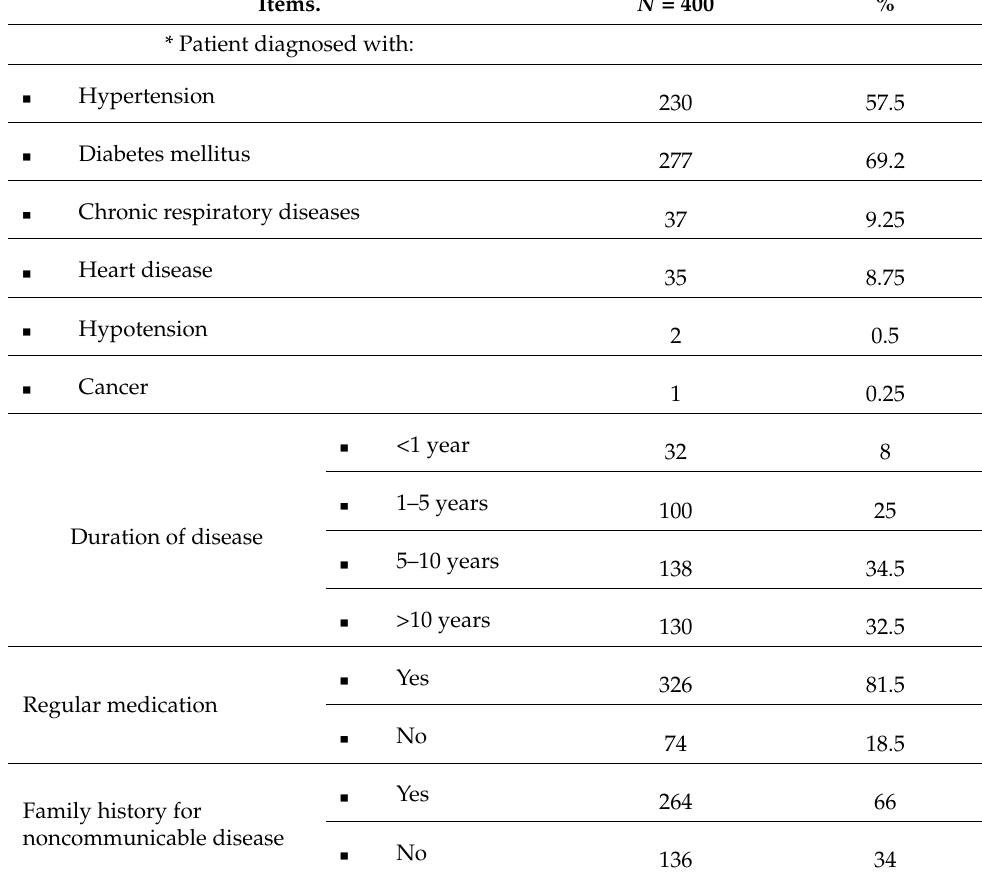
Table 2. Health history of patients in the study.